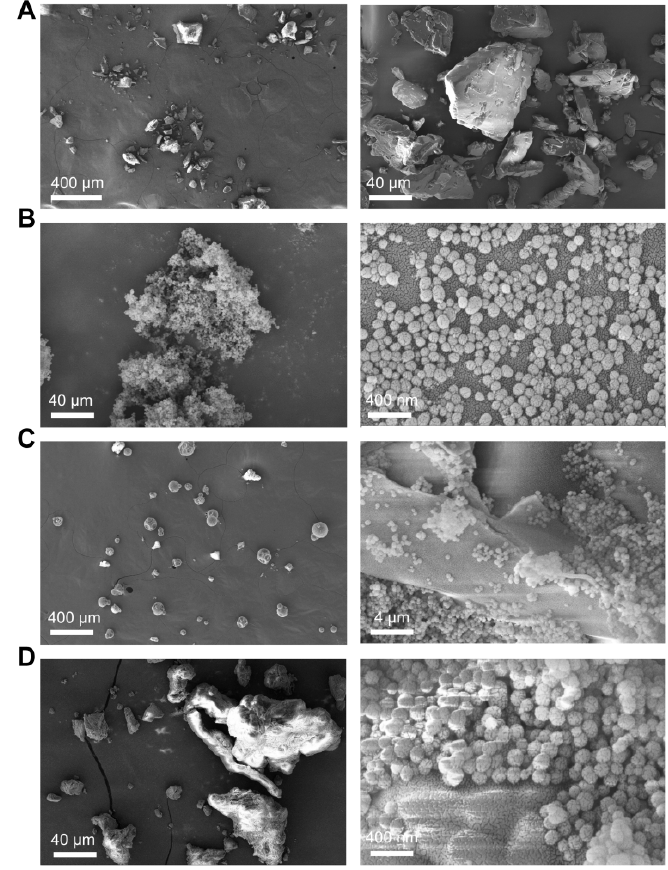
Figure 3. FESEM images of ( A ) pure IMC, ( B ) IMC–MSN (F3), ( C ) IMC–MSN@Kollicoat IR (F6), and ( D ) IMC–MSN@HPMC (F9). Scale bars are as shown in the images.